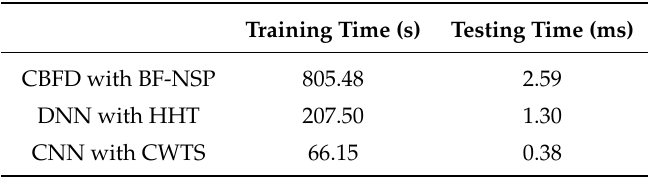
Figure 9. Comparison of CBFD with BF-NSP with other methods. Table 3. Computational time comparison of the convolutional neural network (CNN)-based bearing fault detector (CBFD) with the bearing fault-nested scatter plot (BF-NSP) with other